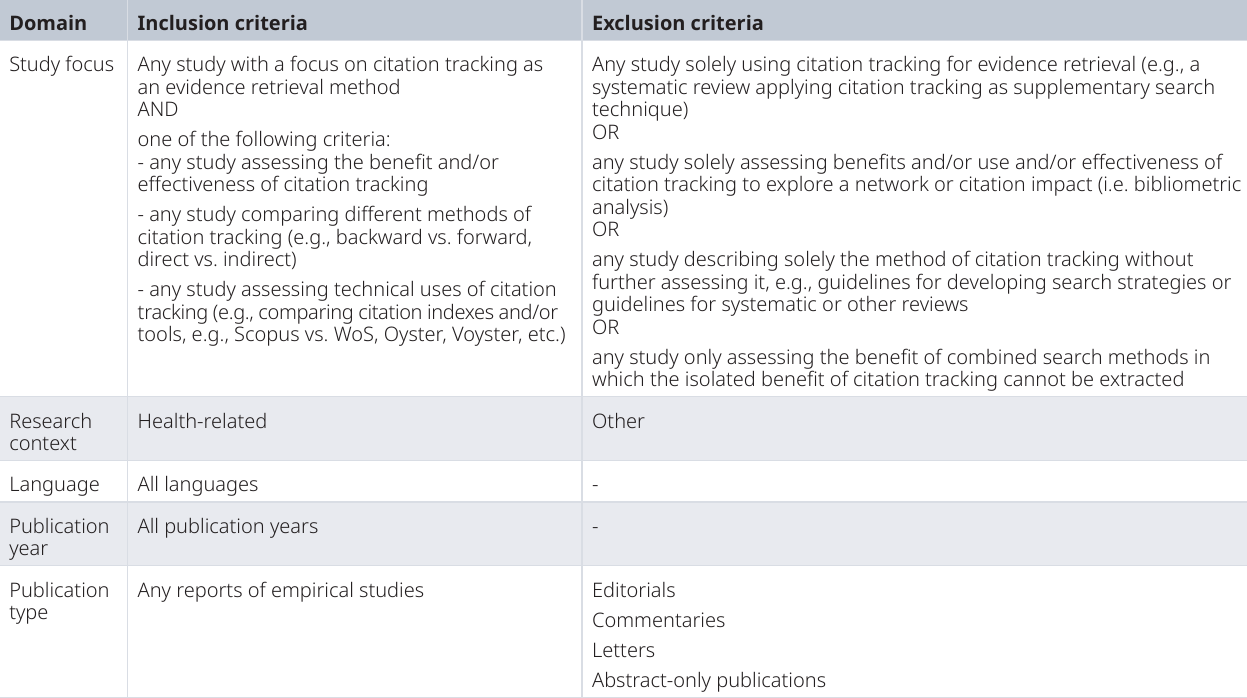
Table 1. Inclusion and exclusion